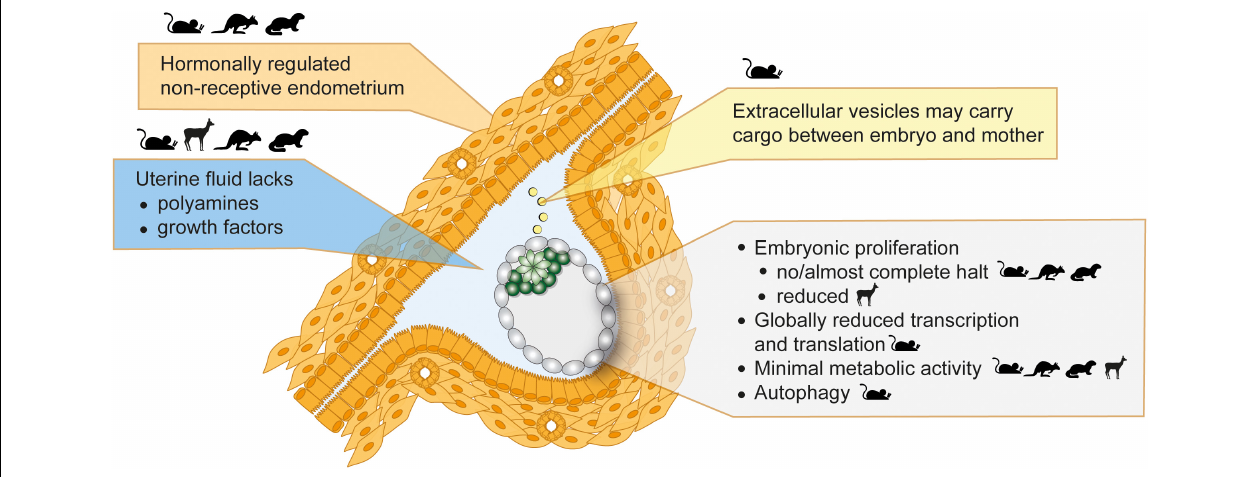
FIGURE 2 | Inducers and features of embryonic diapause. Seasonal variations in photoperiod or lactational stress lead to hormonal alterations. The uterus then fails to establish a receptive state, which blocks implantations and induces diapause. Uterine fluid and extracellular vesicle composition is altered in diapause. The embryo in diapause shows minimal metabolic activity, globally reduced transcription and translation, and diminished or reduced proliferation. Depicted in the figure is a mouse embryo. Parent species where evidence supportive of each statement was derived are shown as